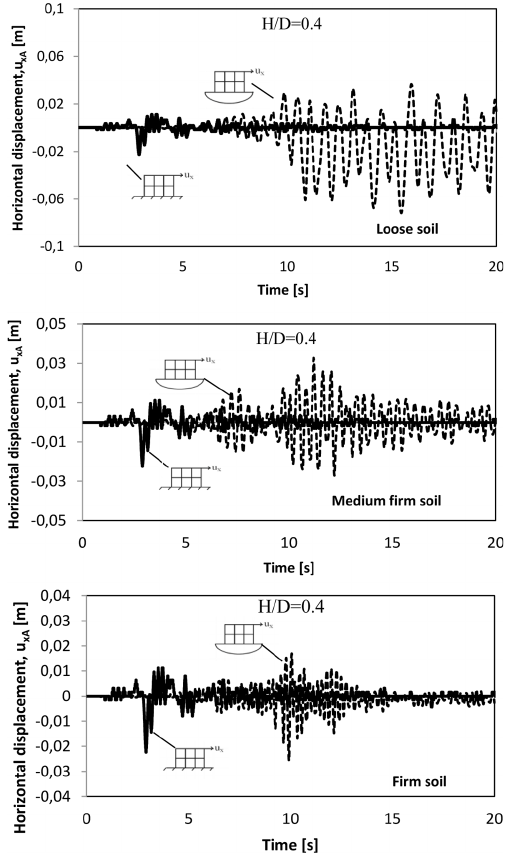
Fig. 7. Variation of lateral displacement time histories at the roof floor of the buildings under consideration of SSI (dashed curves) and fixed-base support (solid curves) in the case of H/D = 4 with different soil conditions for the 1989 Loma Prieta earthquake input motion. Table 6. Material parameters of Mohr-Coulomb model for loose soil considered in FE